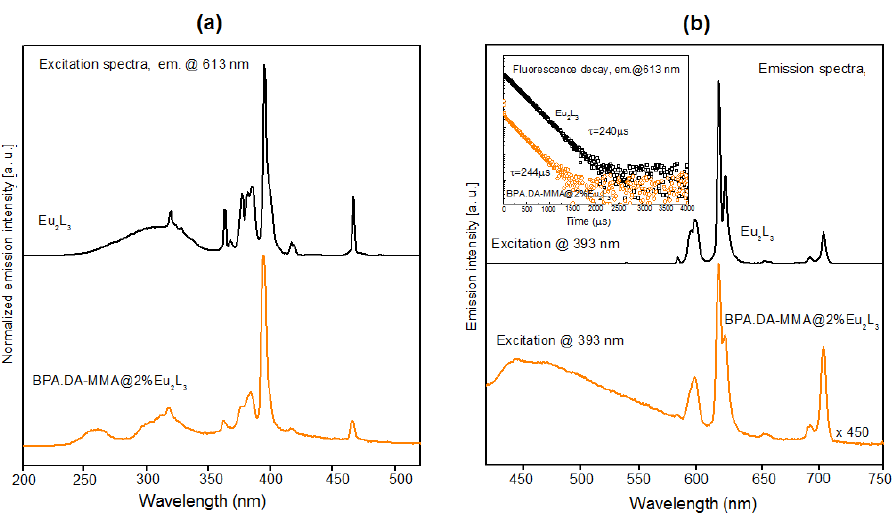
Figure 10. ( a ) Comparison of the excitation characteristics recorded for the Eu 2 L 3 complex and BPA.DA-MMA@2%Eu 2 L 3 composite material (recorded for 613 nm emission). ( b ) Comparison of emission characteristics recorded for the Eu 2 L 3 complex and BPA.DA-MMA@2%Eu 2 L 3 hybrid material (393 nm